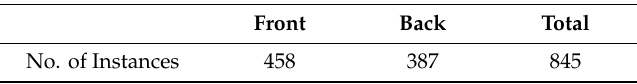
Table 2. Number of front and back side instances in the dataset.